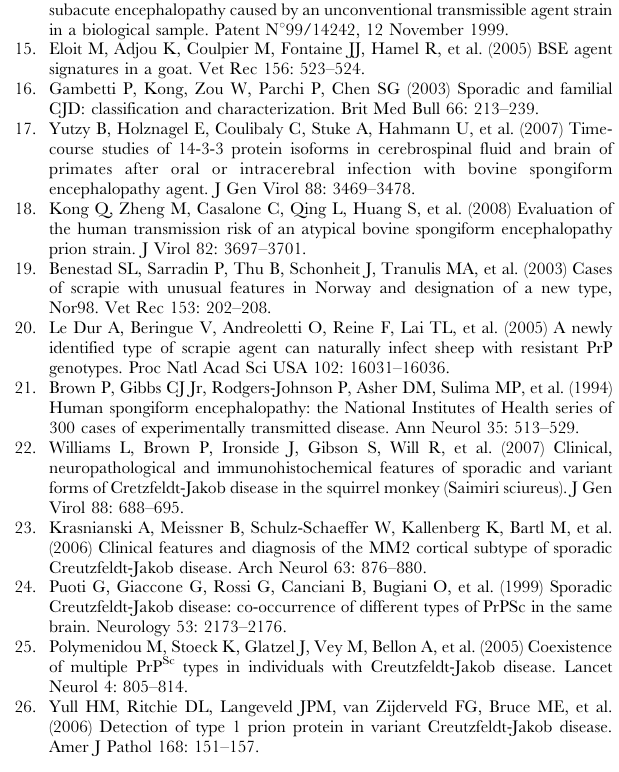
protein. With the lower concentration of PK used in the